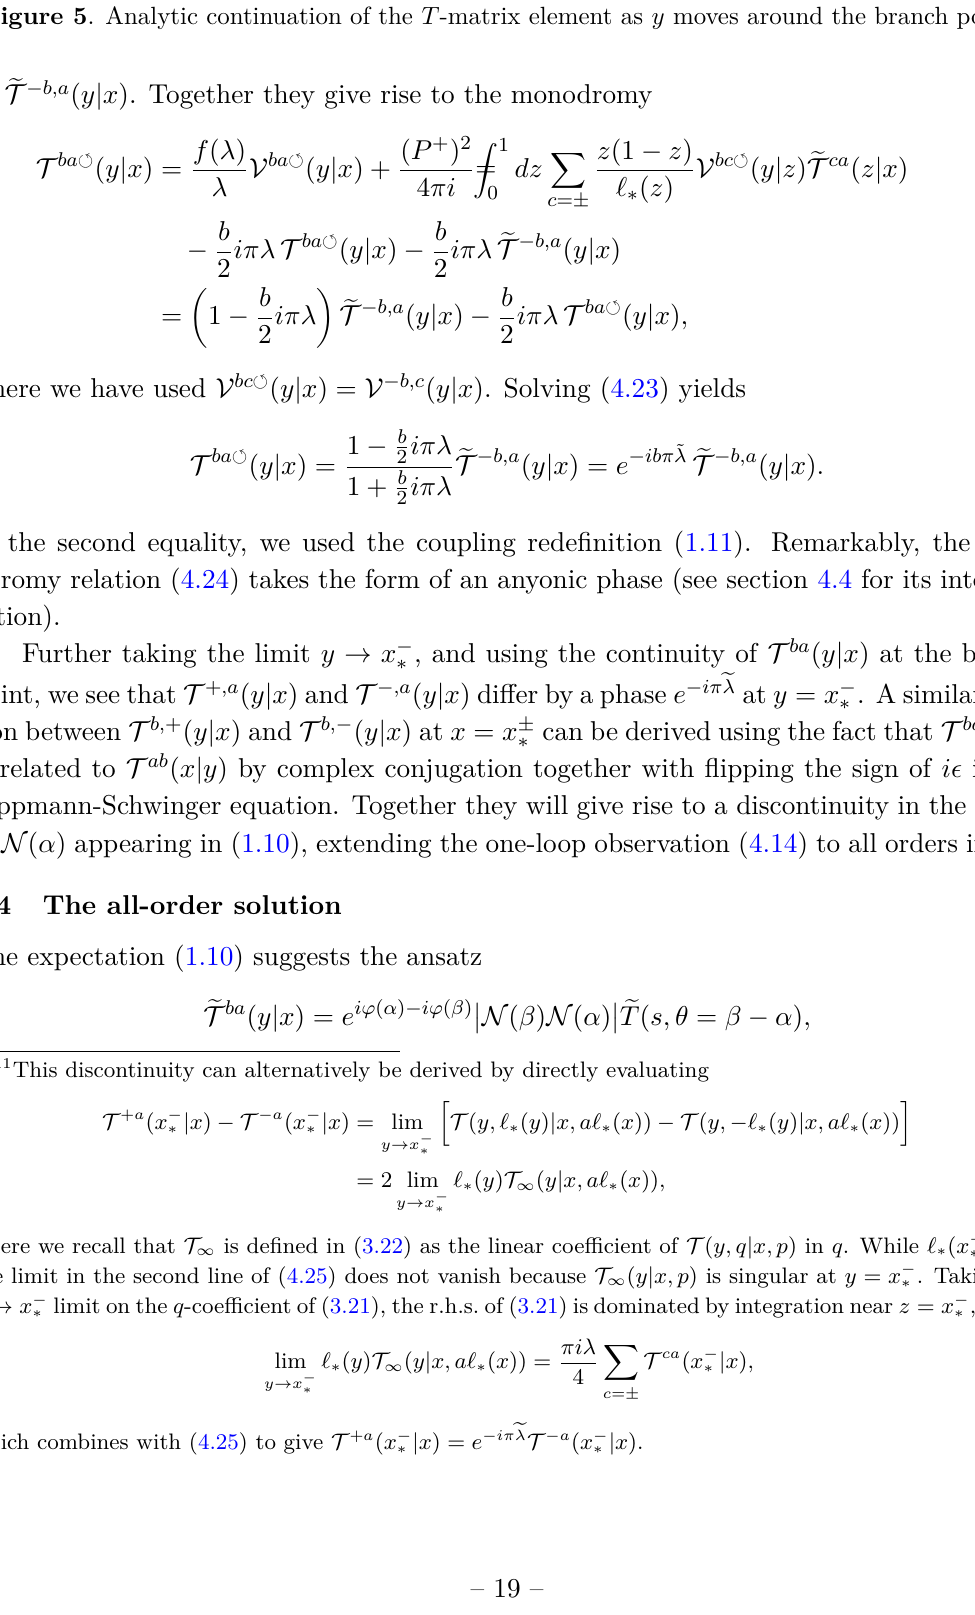
Figure 5 . Analytic continuation of the T -matrix element as y moves around the branch